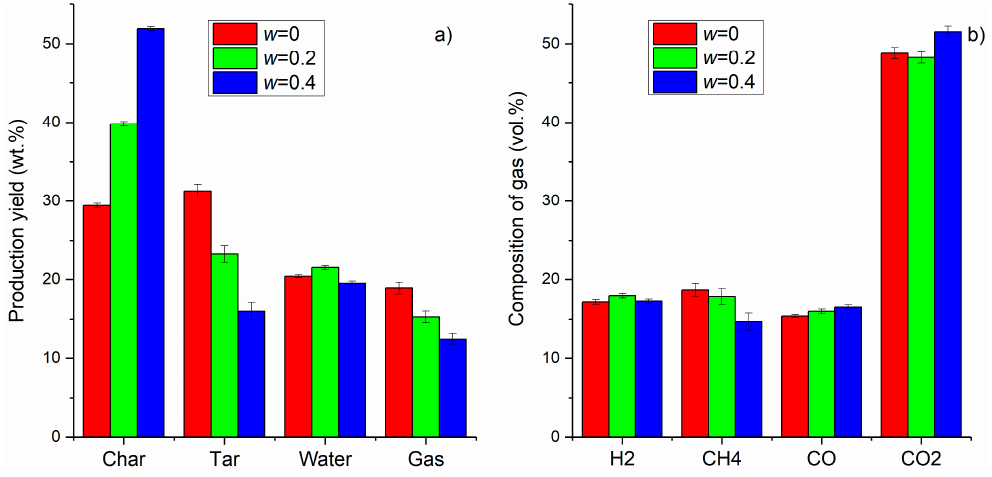
Figure 4. Production yields ( a ) and gas composition ( b ) during pyrolysis at 600 °C.